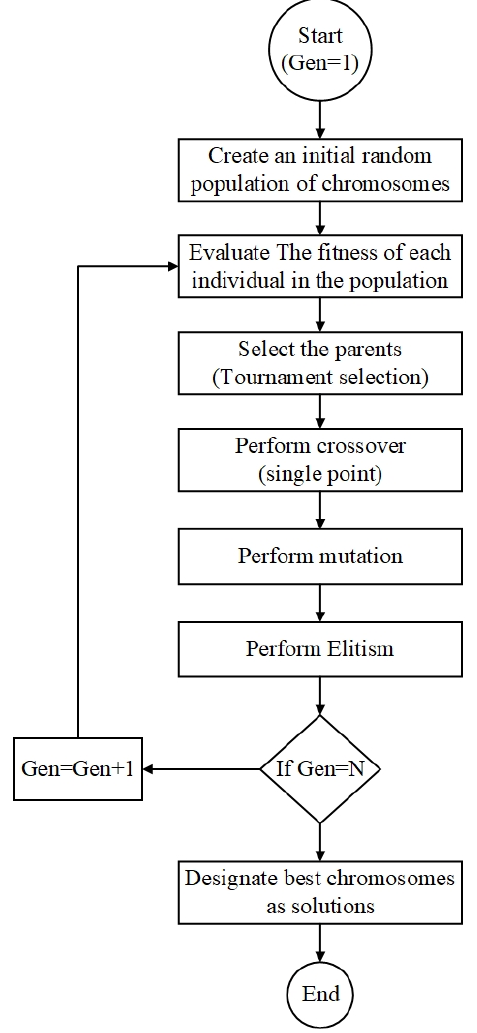
Fig. 9. Flowchart of the genetic